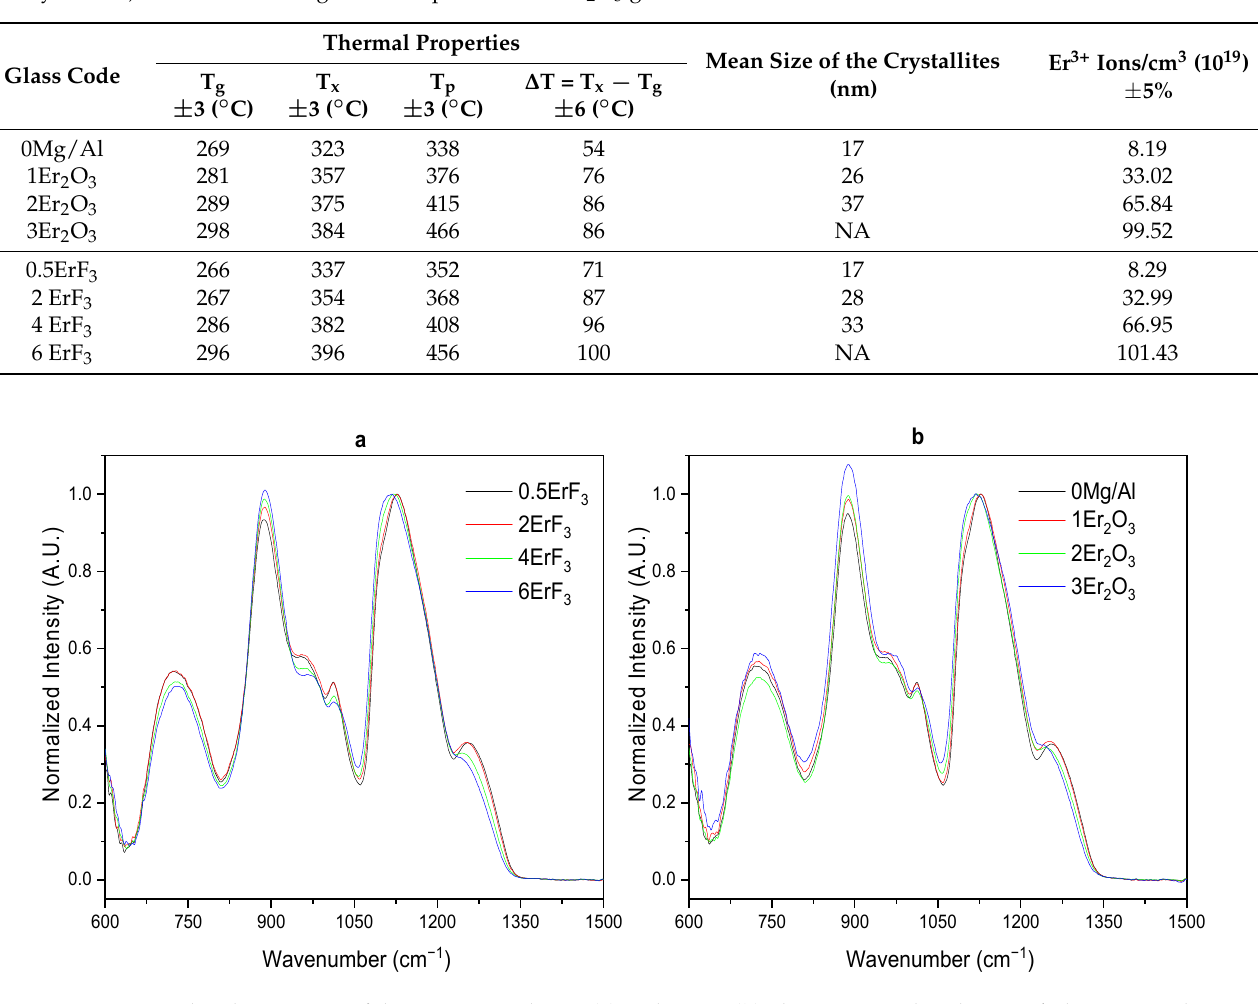
Figure 5. Normalized IR spectra of the investigated ErF 3 ( a ) and Er 2 O 3 ( b ) glasses. Note that the 0Mg/Al corresponds to 0.25Er 2 O 3 glass.